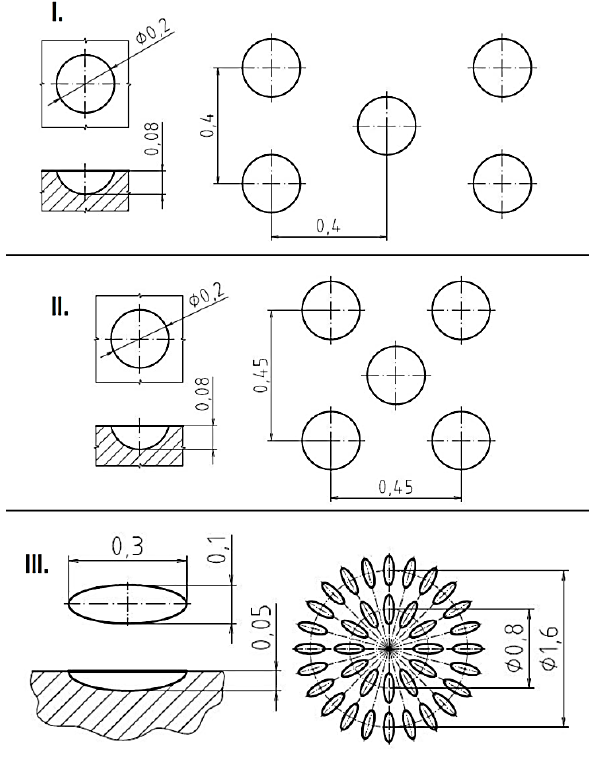
Figure 4: Base element shapes and